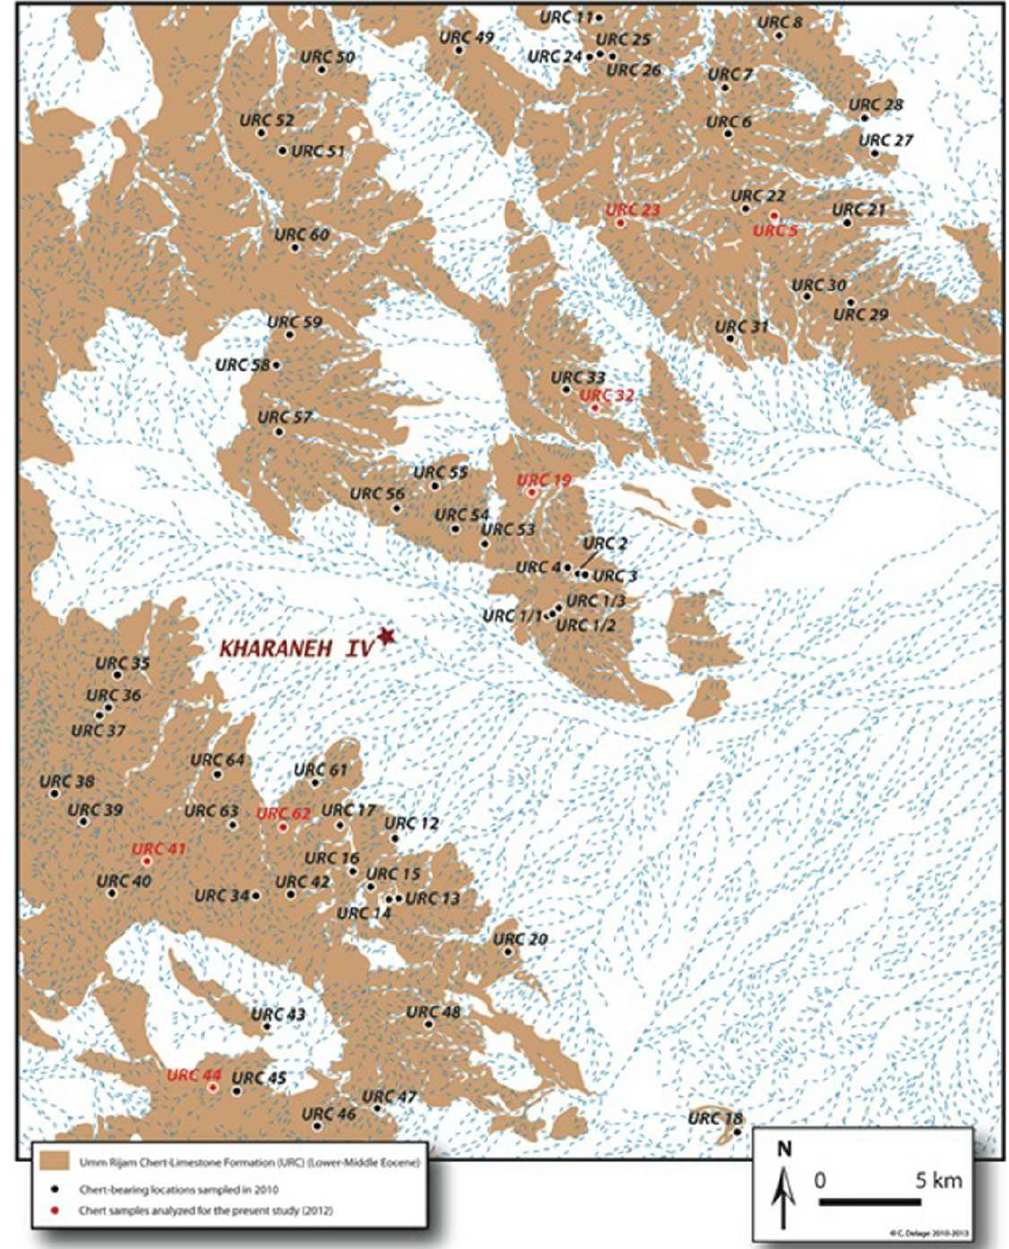
Figure 8. Samples analysed from URC that can be consulted at the moment in our virtual lithotheque (in red colour). Map created by C. Delage